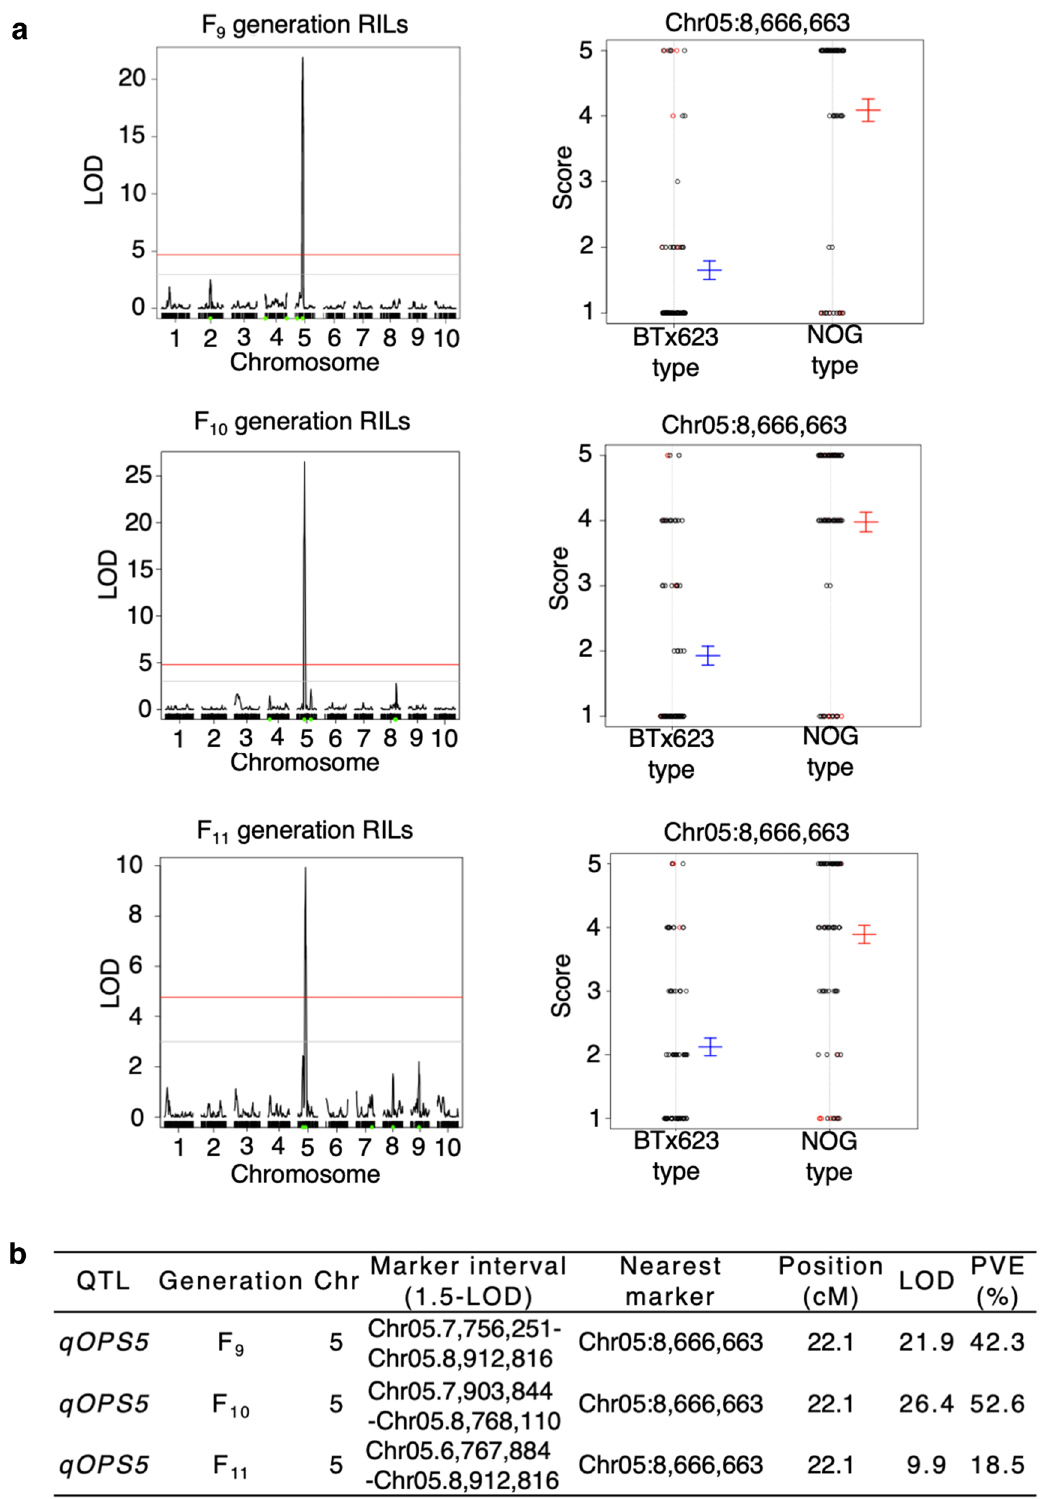
Figure 2. QTL analysis of OPS phenotype with fenitrothion treatment in the F 9 , F 10 , and F 11 RIL populations. ( a ) The logarithm of odds (LOD) graphs for fenitrothion treatment using RILs in each population (left). The gray line represents an LOD threshold = 3, and the red line represents an LOD threshold based on a permutation test with 1000 iterations. Right panel represents plot phenotypes versus marker genotypes analysis corresponding to graphs. ( b ) Summary of QTLs identified in ( a ). The same QTL marker was obtained in the F 9 , F 10 , and F 11 RIL generations. PVE indicates phenotype variation explained. Marker intervals were estimated based on confidence intervals